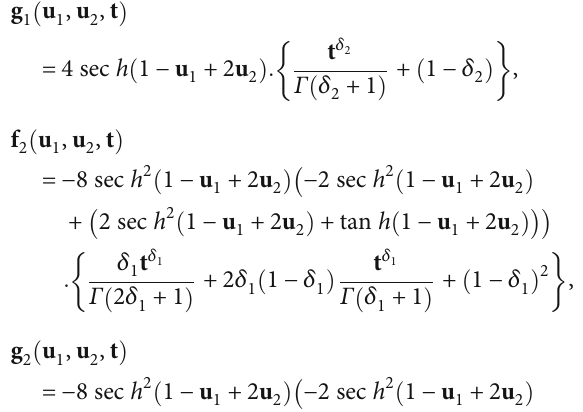
Figure 2: (a) 3D view of absolute error for f ð u when t = 0 : 7